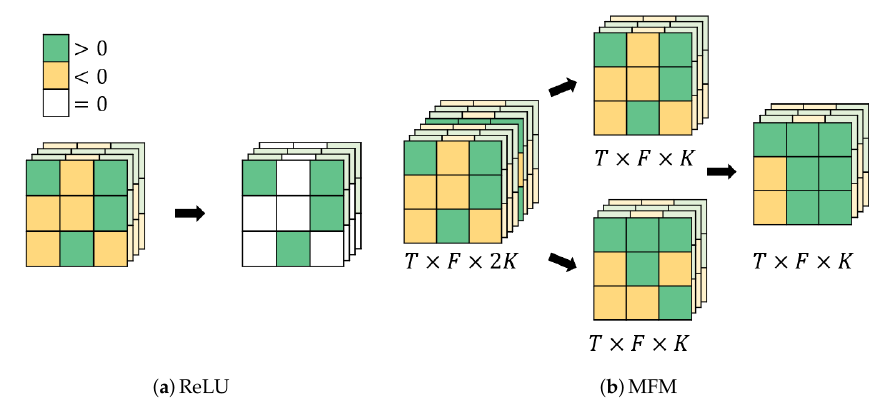
Figure 2. Comparison of ReLU activation function ( a ) and MFM ( b ). Orange, green, and white indicate negative, positive, and zero values, respectively. ReLU removes all negative values, while MFM considers the element-wise